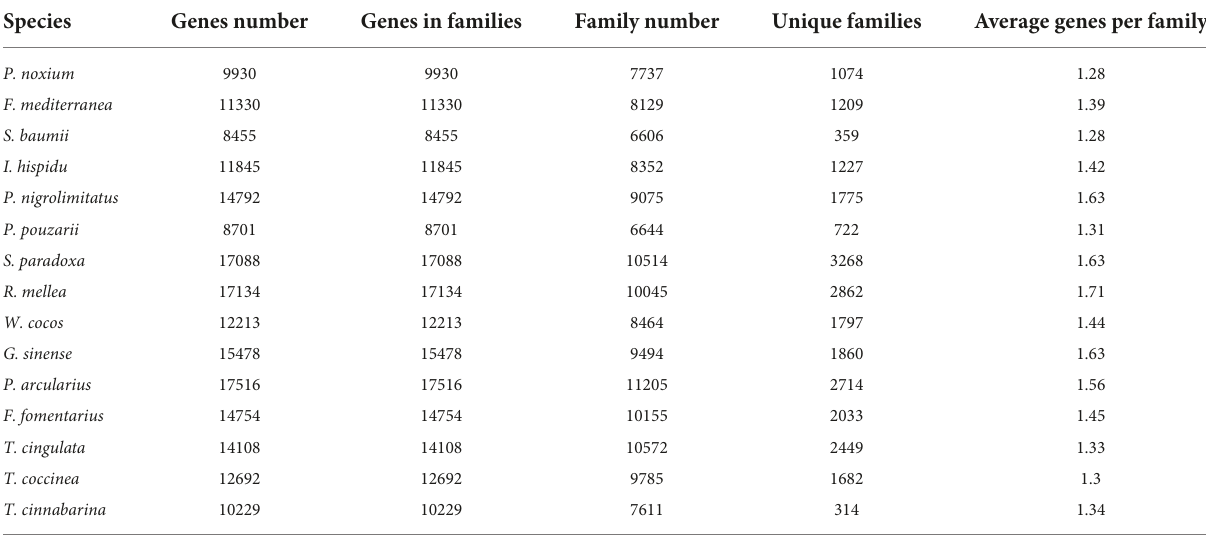
TABLE 4 Statistics table of gene family clustering